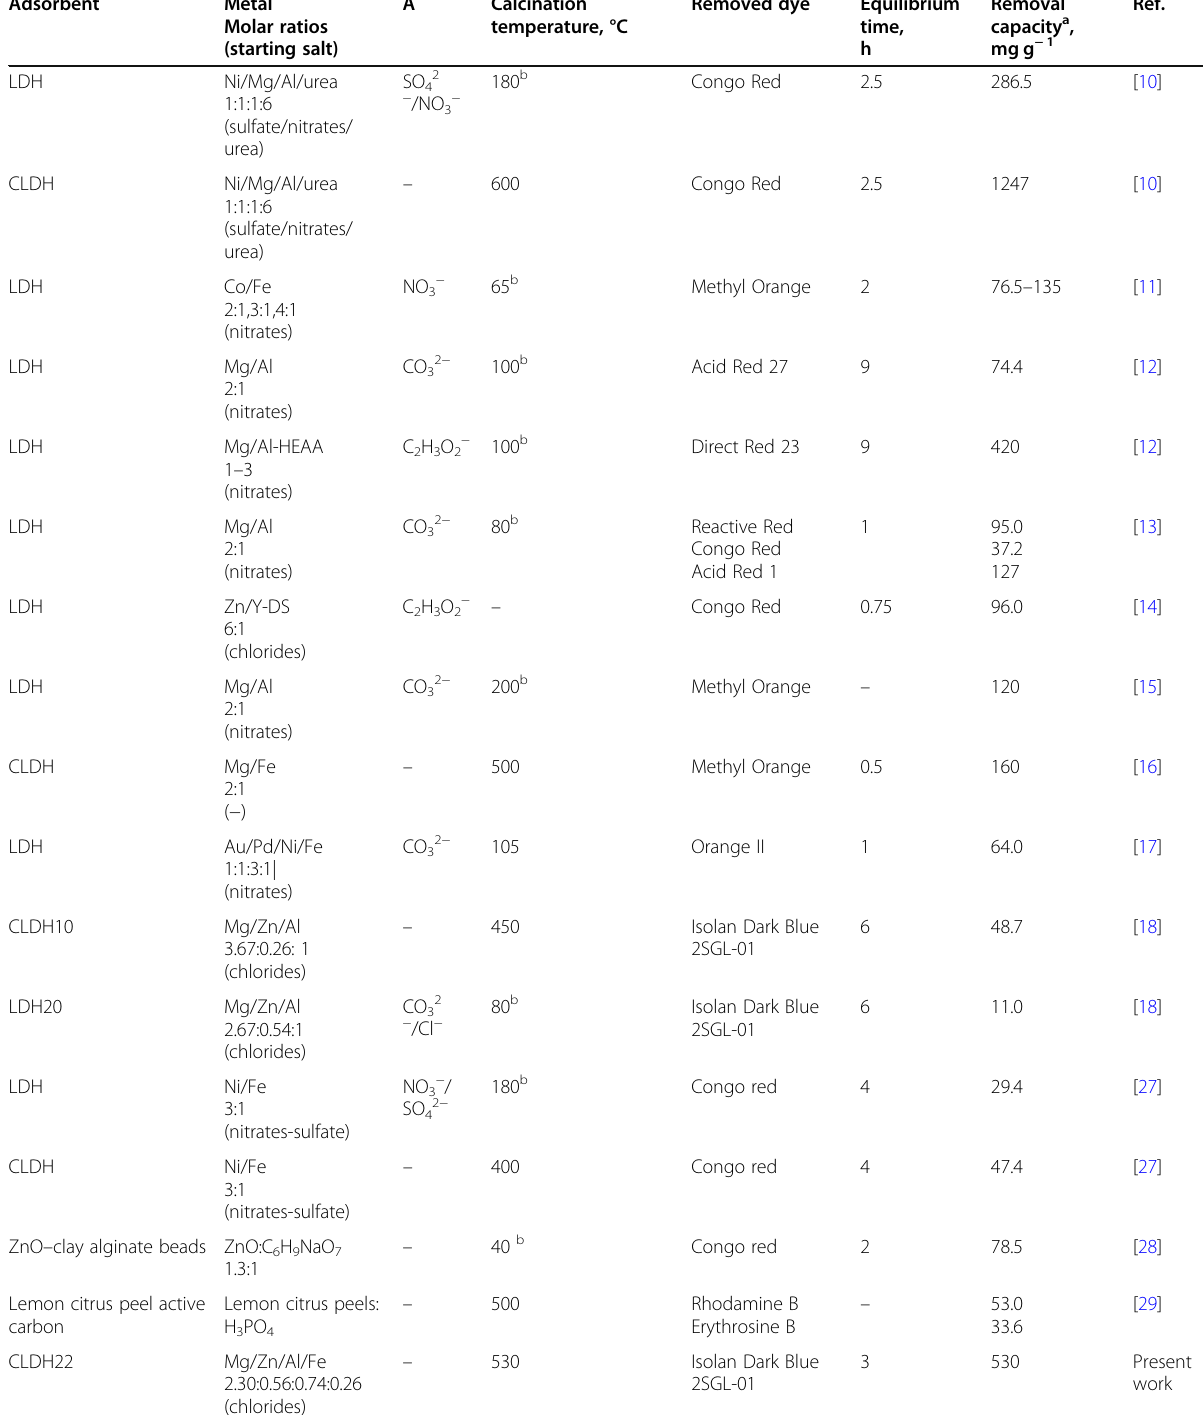
Table 2 Capacities of reported LDHs or CLDHs and common sorbents towards sulfonated dyes compared with CLDH22 Adsorbent Metal Molar